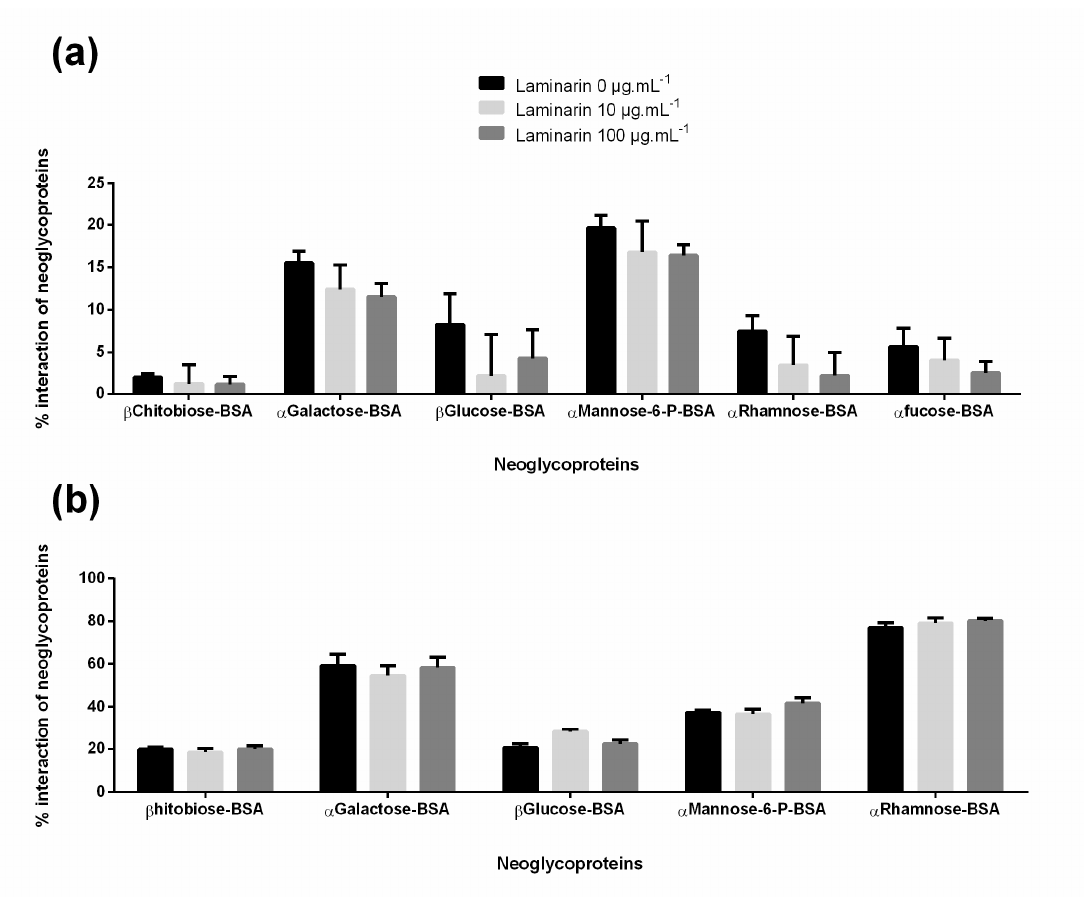
Figure 7. Neoglycoprotein interaction (NeoPROFILE) with ( a ) HDFa (neoglycoproteins: β -Chitobiose-BSA, α -Galactose-BSA, β -Glucose-BSA, α -Mannose-6-Phosphate-BSA, α -Rhamnose-BSA, α -Fucose-BSA) and with ( b ) NHEK (neoglycoproteins: β -Chitobiose-BSA, α -Galactose-BSA, β -Glucose-BSA, α -Mannose-6-Phosphate-BSA, α -Rhamnose-BSA) after stimulation with laminarin for a stimulation time of 72 h before the analysis; black laminarin at 0 µg.mL − 1 , grey laminarin at 10 µg.mL − 1 , dark grey laminarin at 100 µg.mL − 1 . Data are expressed as mean ± SD of two independent experiments.